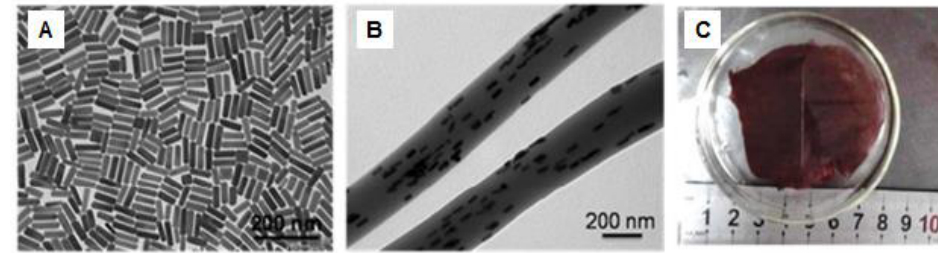
Figure 8. TEM images of ( A ) Au nanorods (AuNRs), ( B ) AuNRs/PNIPAM electrospun fibers and ( C ) photograph of AuNRs/PNIPAM composite film immersed in water. Reprinted with permission from reference [97]. Copyright ACS Publications,